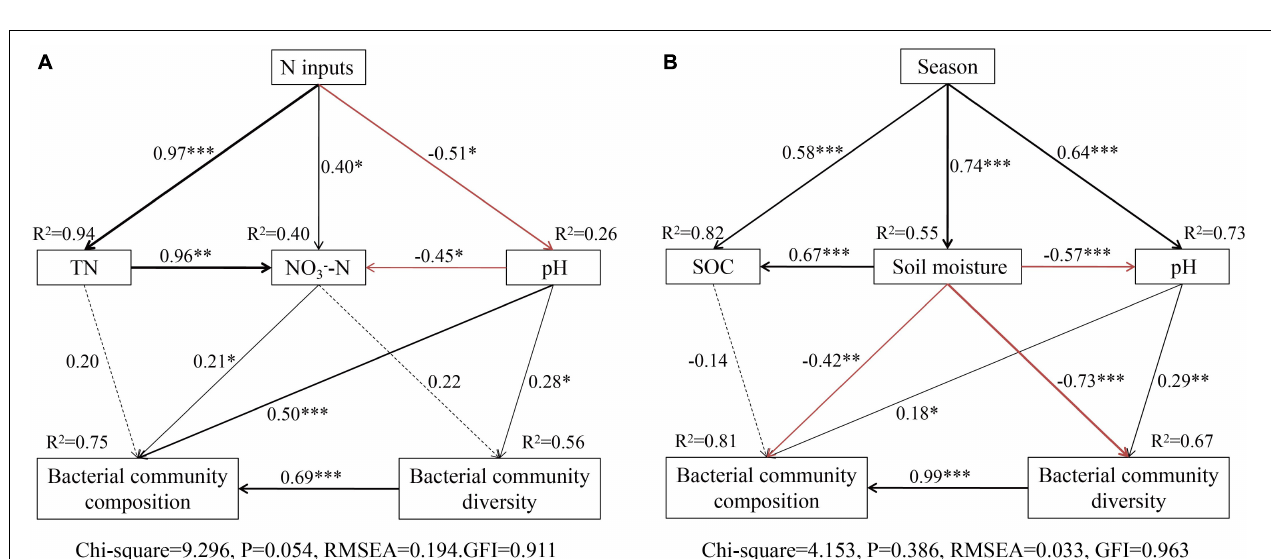
FIGURE 6 | The spearman correlation heatmap of the dominant bacterial phyla (A) and genera (B) and soil properties. The X and Y axes represent the environmental factors and phyla (or genera), respectively. R in different colors to show, the right side of the legend is the color range of different R values. * P < 0.05; ** P < 0.01.